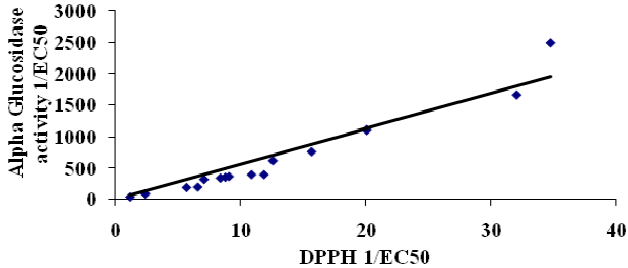
Figure 2. Correlation between  -glucosidase assay (antihyperglycemic) and DPPH assay (antioxidant). Correlation = 0.9734.